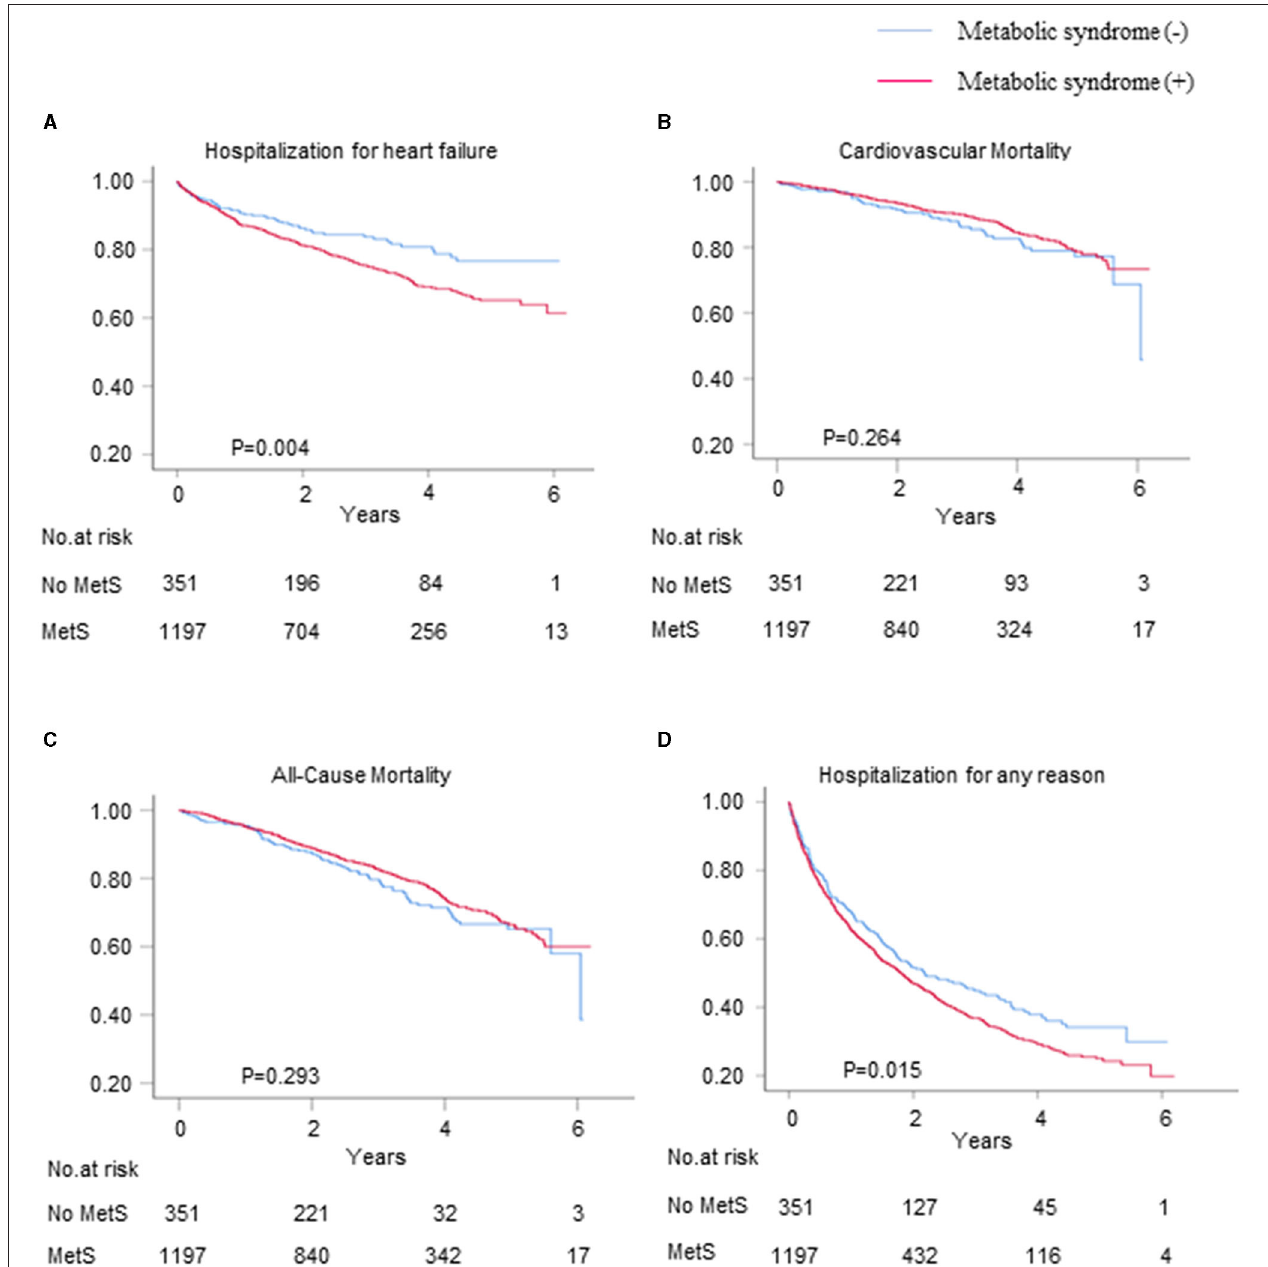
FIGURE 2 | The Kaplan–Meier survival curves and cumulative event rates for the primary and secondary outcomes. The hospitalization rates for (A) heart failure (HF), (B) cardiovascular (CV) mortality, (C) all-cause mortality, and (D) hospitalization for any reason.